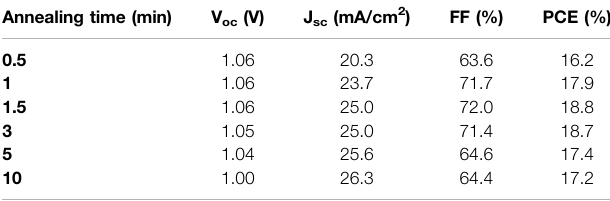
TABLE 4 | Summary of the cell characteristics measured under AM 1.5G conditions for MAPbI 3 fi lms crystallized at 200 ° C for different annealing time. Annealing time